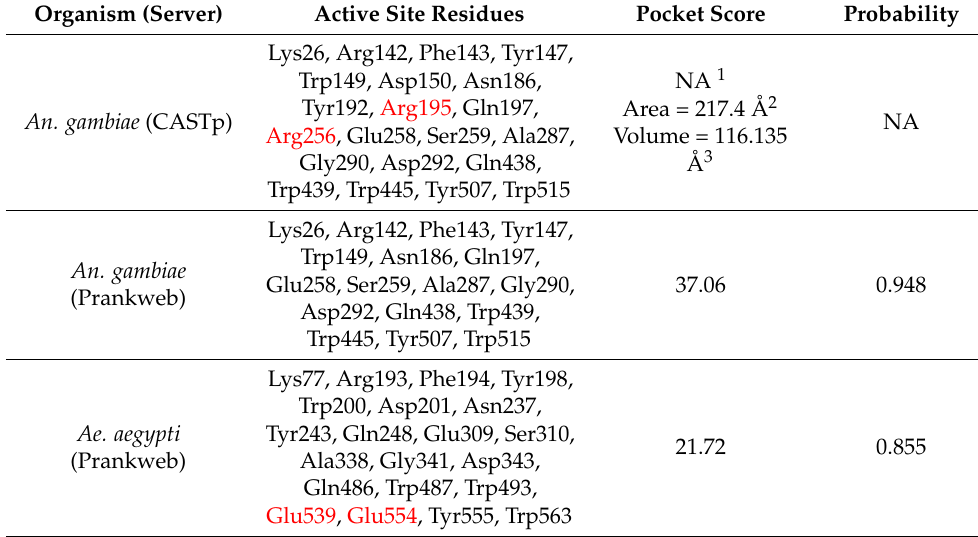
Table 2. Predicted active site residues for trehalase of An. gambiae and Ae. aegypti . Organism (Server) Active Site Residues Pocket Score